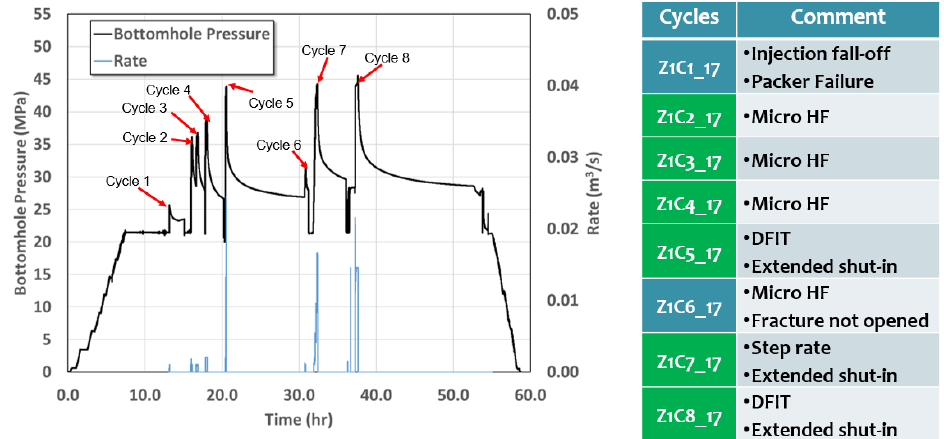
Figure 5. Pressure-rate relationships during the 2017 injection testing of Zone 1 (Z1) during Cycles 1–8 (C1–8). The cycle designation indicates the zone, the cycle number, and the year the measurements were made. HF = hydraulic Fracture and DFIT = Diagnostic Fracture Injection Test.